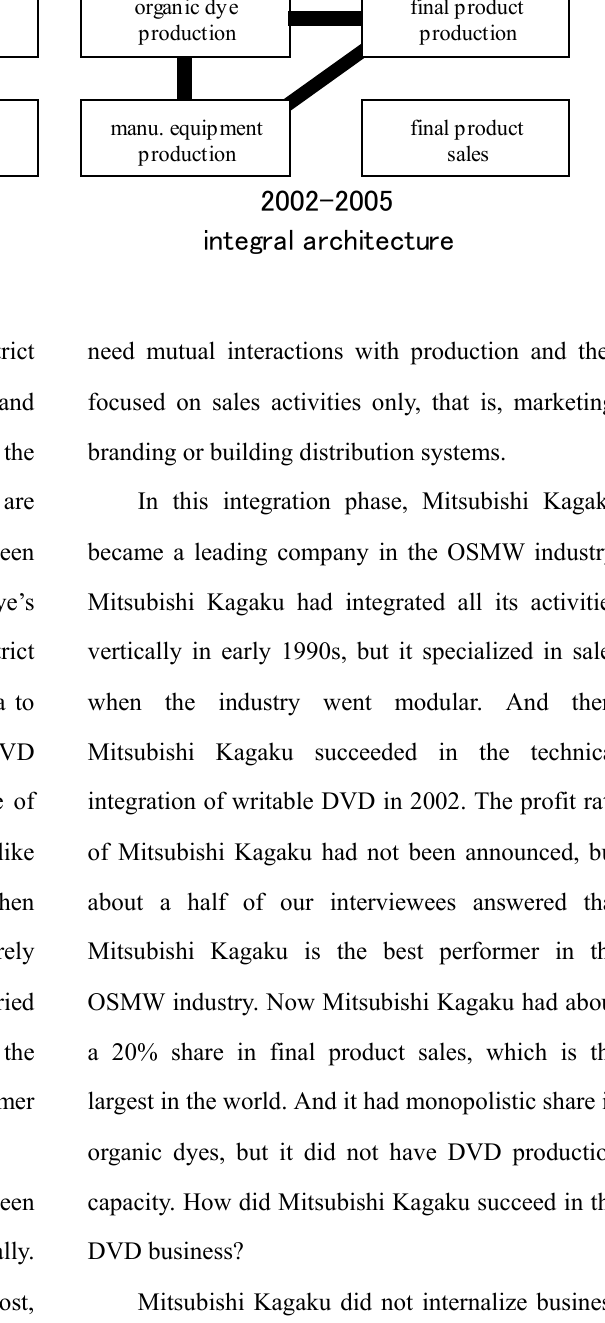
organic dye production